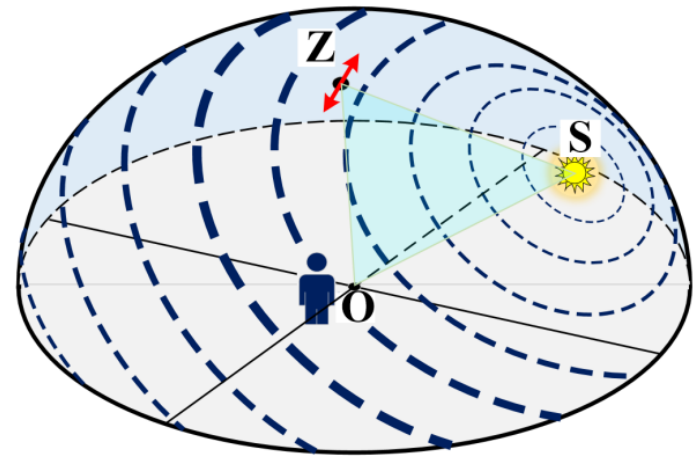
Figure 1. The sketch map of the skylight polarization pattern; the thickness and orientation of the arcs indicate the degree and direction of polarization, respectively.